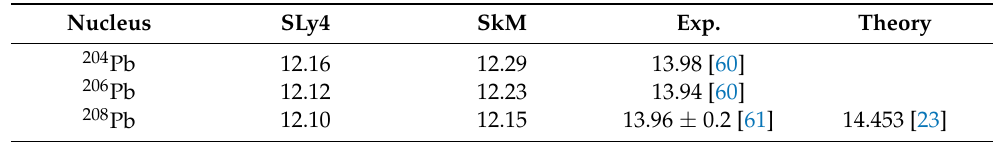
Table 3. The values of the centroid energies E ISGMR (in MeV) of Pb isotopes obtained from HF+CDFM calculations in this work using SLy4 and SkM Skyrme forces compared with the experimental data found in the